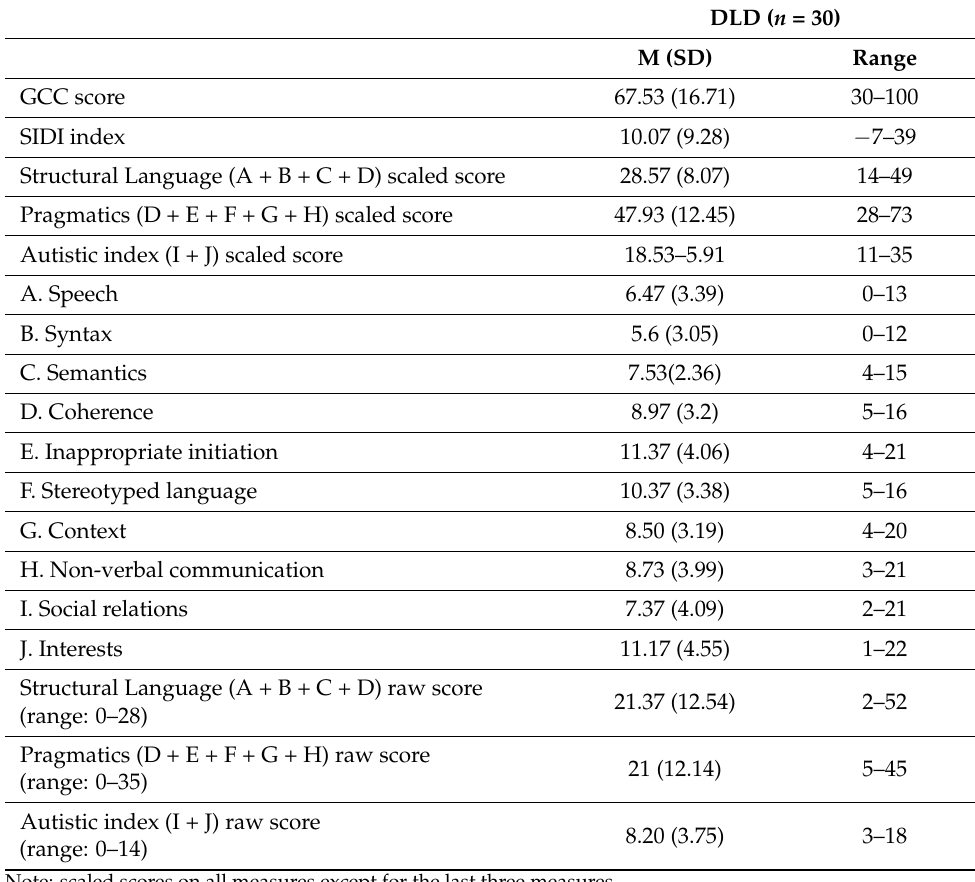
Table 3. Descriptive statistics of Developmental Language Disorder (DLD) participants on Children’s Communication Checklist-2 (CCC-2) scores.